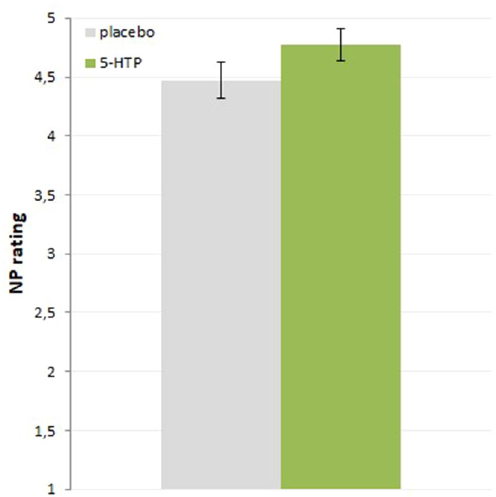
Figure 3. Moral judgement task behavioral effect of substance on the reprehensibility ratings (1–7, 7 very reprehensible) of the moral stories with a good ending although the protagonist behaved badly (NP condition), significantly higher NP rating after 200 mg 5-HTP intake compared to placebo (n = 77; cross-over design); means with SE; see baseline values of placebo condition for all 4 categories in supplemental Fig.